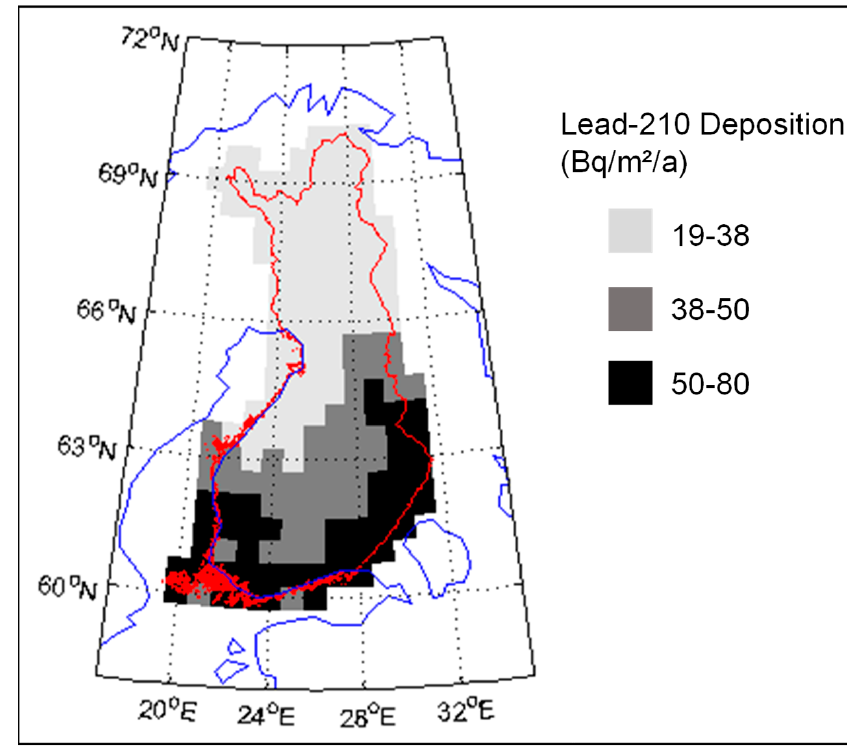
Figure 1. Deposition of 210 Pb (Bq/m 2 /a) in Finland. Original data is published in [9]. 210 Po is enriched from soil to plants via root uptake [11,12] and in less extent via foliar uptake. Lichens behave differently than plants as 210 Po transfers and enriches from air and surface soil to lichens mainly by surface (aerial) uptake [13]. 210 Pb, a grandmother radio- nuclide of 210 Po, has a different chemical and radiochemical behaviour than 210 Po, although